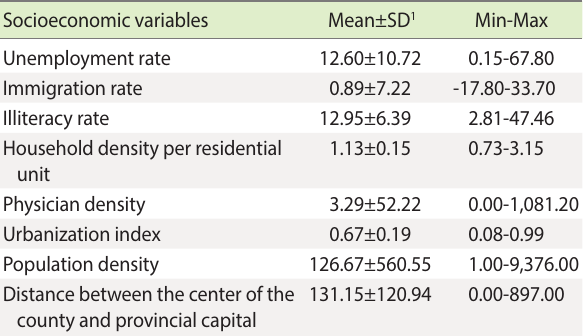
Table 2. Descriptive characteristics of socioeconomic variables